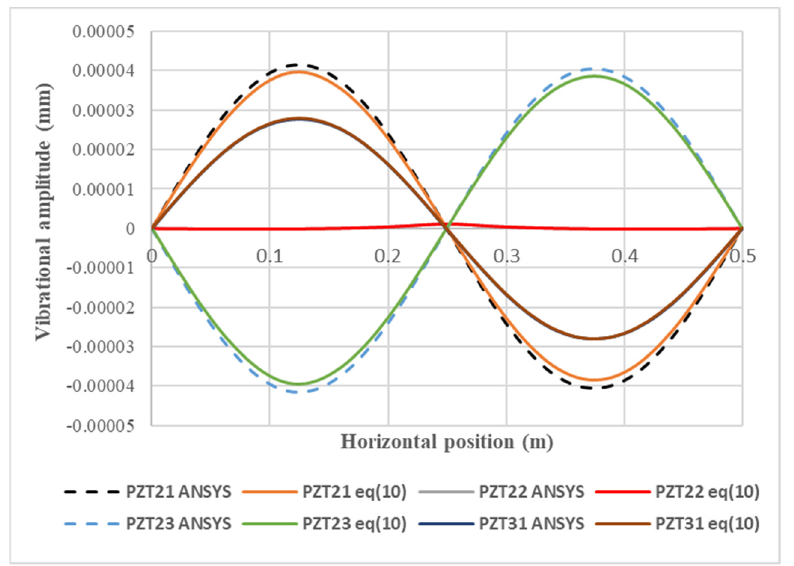
Figure 12. Vibrational amplitude (unit: mm) of a composite laminate plate excited by the PZT 21 actuator with frequency of 396 Hz.